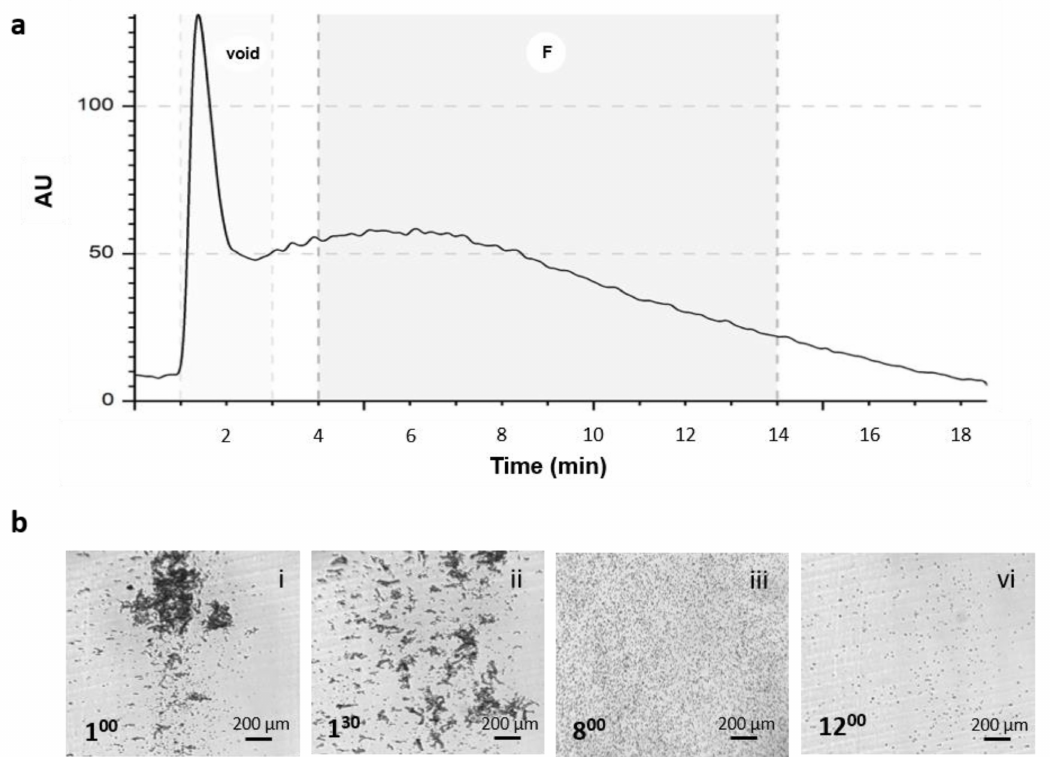
Figure 2. Analysis of fresh stromal vascular fraction (SVF) sample using the Non-Equilibrium Earth Gravity Assisted Field Flow Fractionation (NEEGA-DF) method. ( a ) Representative fractogram of fresh SVF cells showing absorbance versus time of analysis. ( b ) Representative images of eluting cells collected at different times of analysis. In particular, it shows cells eluting in the initial phase (void), when debris, dead cells, red blood cells, and extracellular matrix complexes exited the channel ( i , ii ), as well as single cells later in the analysis belonging to the fraction F ( iii , iv